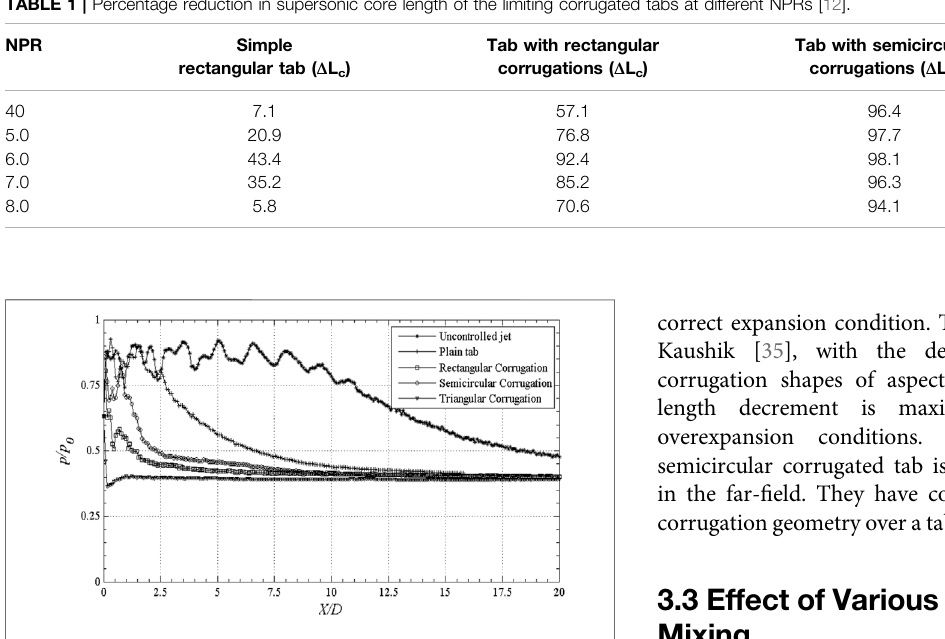
FIGURE 8 | Centerline pressure decay for Mach 1.73 jet at near correct expansion condition